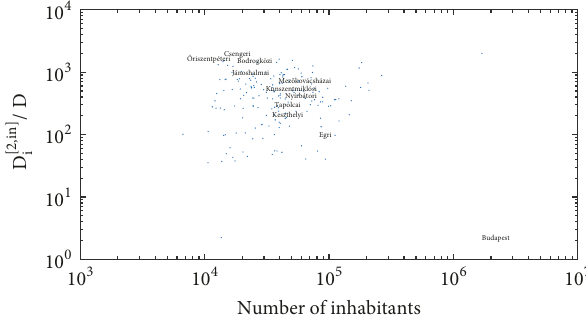
Figure 3: Network density as a function of the number of inhabi- tants on the level LAU